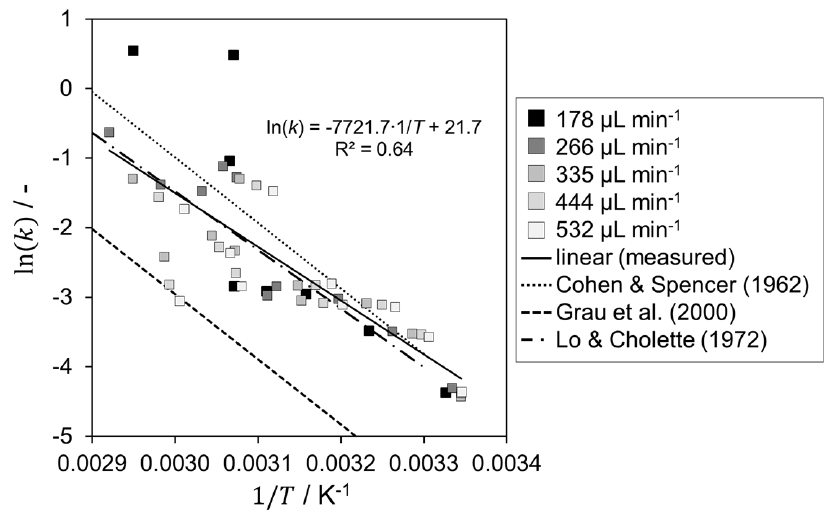
Figure 6. Arrhenius plot for sodium thiosulfate oxidation using hydrogen peroxide in LTF-MS in comparison with literature [33,34,36].